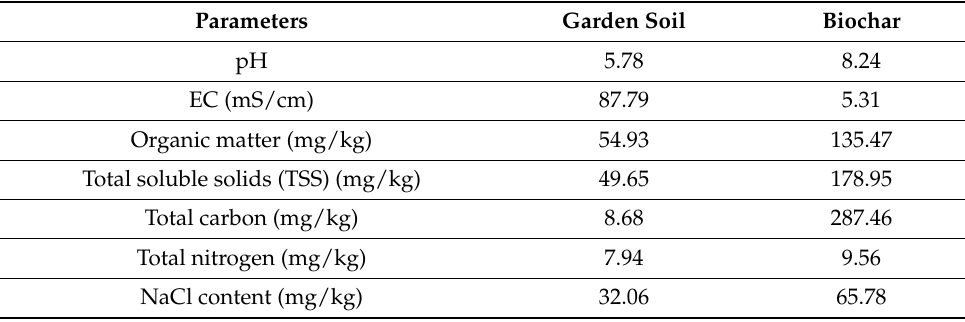
Table 1. The physio-chemical properties of garden soil and